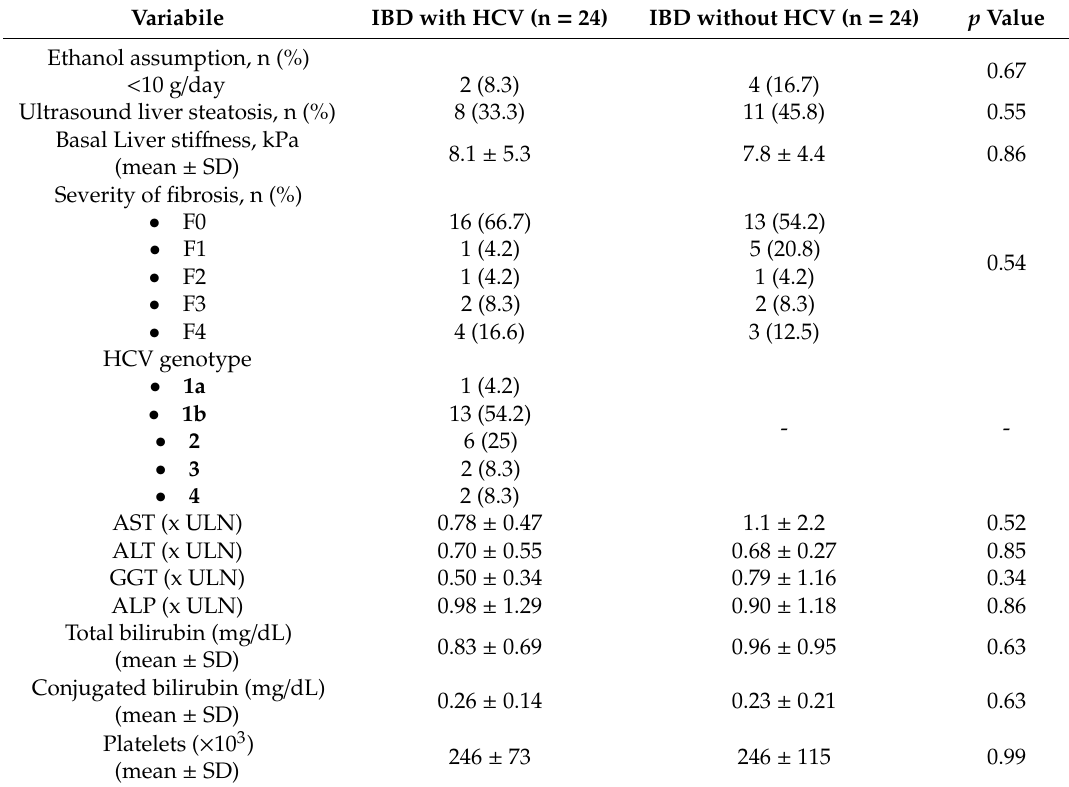
Table 2. Comparison of characteristics of liver profile in patients with IBD with or without HCV at